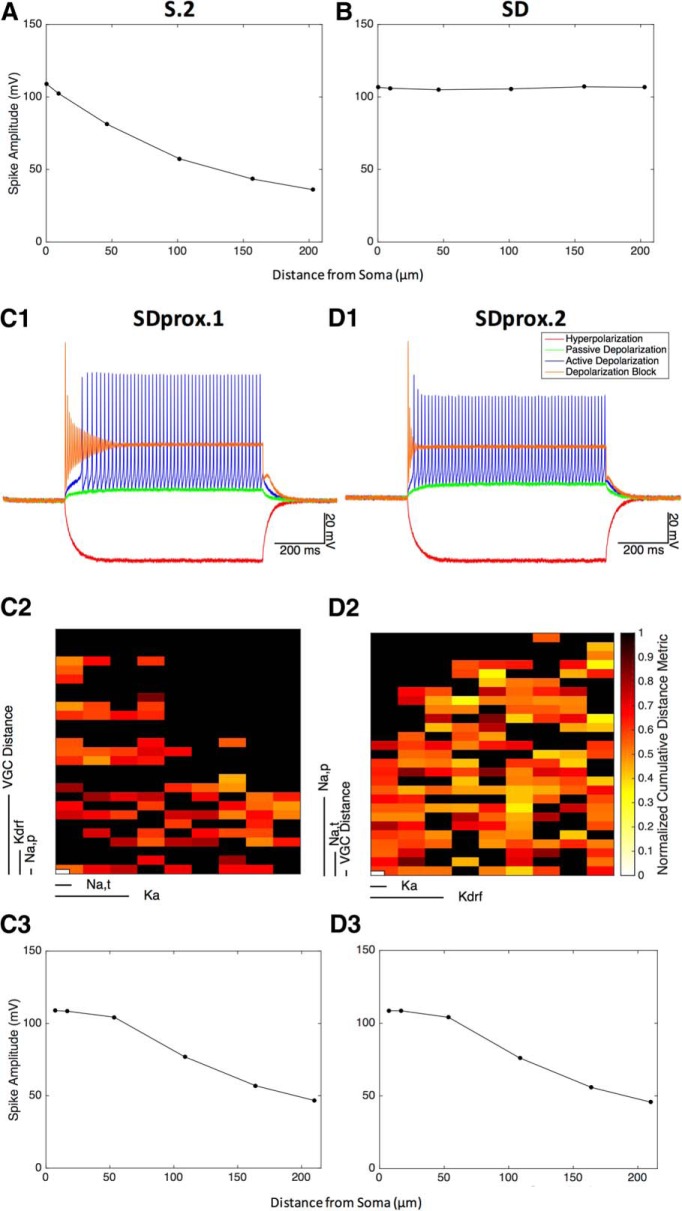
VGC distributions in proximal dendrites. A, Action potential amplitude deterioration along a dendrite section (tree 1) in the S.2 top model following a somatic 800 pA current injection for 2 ms (GNa,t soma = 0.25 S/cm2; GNa,p soma = 0.0001 S/cm2; GKa soma = 0.15 S/cm2; GKdrf soma = 1 S/cm2). B, Action potential amplitude deterioration along a dendrite section (tree 1) in the SD top model following a somatic 800 pA current injection for 2 ms (GNa,t soma/dendrites = 0.06 S/cm2; GNa,p soma = 0.0002 S/cm2; GKa soma/dendrites = 0.1 S/cm2; GKdrf soma/dendrites = 0.1 S/cm2). C1, SDprox.1 top model with channels that are uniform from the soma until the first 70 μm of the dendrites using the Boltzmann function. Conductance values are as follows: GNa,t soma/dendrites = 0.07 S/cm2; GNa,p soma = 0.000075 S/cm2; GKdrf soma/dendrites = 0.25 S/cm2; GKa soma/dendrites = 0.07 S/cm2. Note that the current injection protocol is −100, +20, + 50, and +500 pA. C2, Parameter spaces for SDprox.1, as visualized using CBDR. Note that 70 of 243 models did not get rejected. C3, Action potential amplitude deterioration along a dendrite section (tree 1) in the above SDprox.1 top model following a somatic 800 pA current injection for 2 ms. D1, SDprox.2 top model with channels that are uniform from the soma until the first 70 μm of the dendrites using the Boltzmann function. Conductance values are as follows: GNa,t soma/dendrites = 0.055 S/cm2; GNa,p soma = 0.00015 S/cm2; GKdrf soma/dendrites = 0.295 S/cm2; GKa soma = 0.07 S/cm2. Note that the current injection protocol is −100, +20, + 50, and +500 pA. D2, Parameter spaces for SDprox.2, as visualized using CBDR. Note that 146 of 243 models did not get rejected. D3, Action potential amplitude deterioration along a dendrite section in the above SDprox.2 top model following a somatic 800 pA current injection for 2 ms.